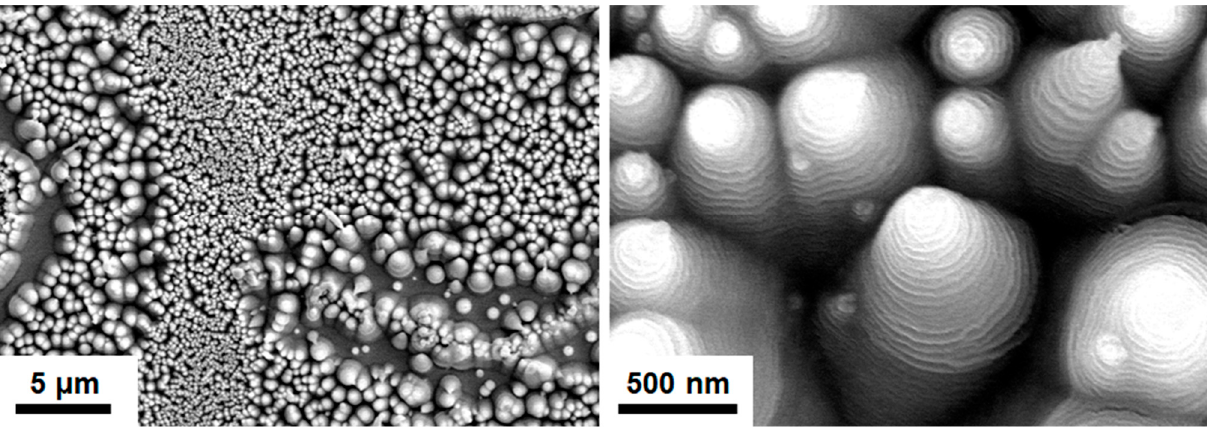
Figure 13. XSEM images of the T2 and T1 samples annealed at 600 °C in 1% O 2 –Ar for 8 h.